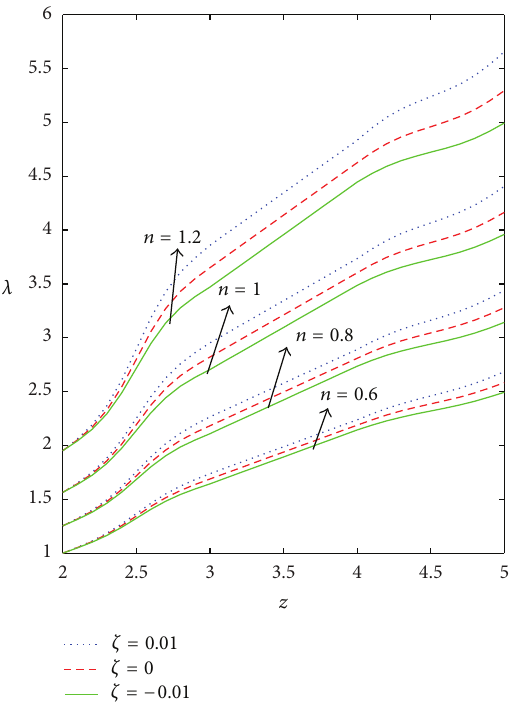
Figure 12: Axial variation of flow resistance ( 𝜆 ) for different values of yield stress ( 𝜏 𝑦 ) taking 𝑛 = 0.8 , 𝑘 = 1.2 , and 𝛿 = 0.2 .